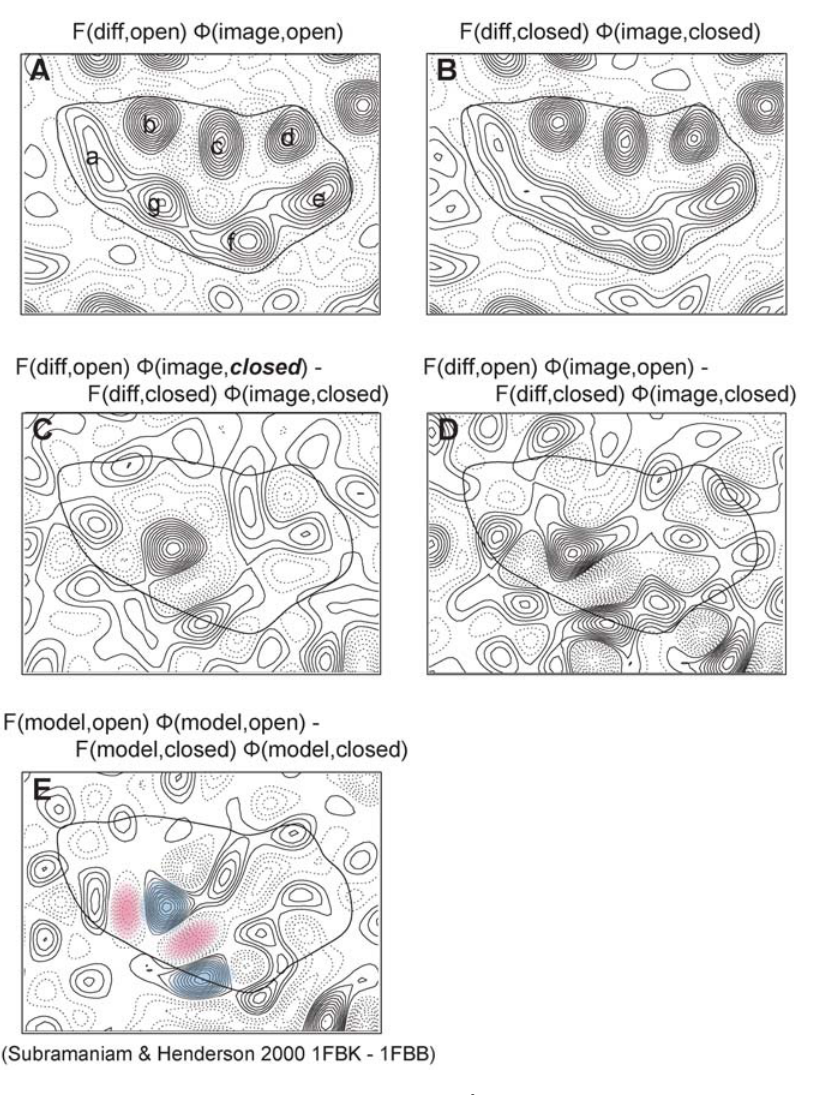
Figure 10. Maps calculated using EM data at 7 A˚. Amplitude data for closed and open states from diffraction analysis alone (F (diff, open) , F (diff, closed) ) were obtained as described in the text. These amplitude data were used to build models for 1FBB and 1FBK [27]. Phase data for closed state ( w (image, closed) ) are the same as those of Henderson et al [3]. Phase data for open state ( w (image, open) ) were calculated as described in the text. (A) Projection map of open state, F (diff, open) w (image, open) . Amplitude data is from diffraction patterns and phase data is from images. (B) Projection map of closed state, F (diff, closed) w (image, closed) . Amplitude data is from diffraction patterns and phase data is from images. (C) Difference map, F (model, open) w (model, closed ) - F (model, closed) w (model, closed) . Phase information comes only from the model of the closed (i.e. unilluminated) state. The absence of phase information is a common situation when molecular replacement is used in X-ray or electron crystallography. (D) Difference map, F (diff, open) w (image, open) - F (diff, closed) w (image, closed) . For both open and closed states, amplitude data is from diffraction patterns and phase data is from images of each state. (E) Difference map, F (model, open) w (model, open) - F (model, closed) w (model, closed) . All amplitude and phase data are calculated from coordinates 1FBK and 1FBB. The pair of positive (blue) and negative (magenta) peaks correspond to the movements of the cytoplasmic end of helix F, the EF loop and cytoplasmic end of helix G. map calculated from models supports the movements of helices F and G obtained by electron crystallographic analysis. As shown in Figs. 5–9, only the 1FBK set of coordinates derived by electron crystallography shows a calculated difference map that matches the experimentally observed map.